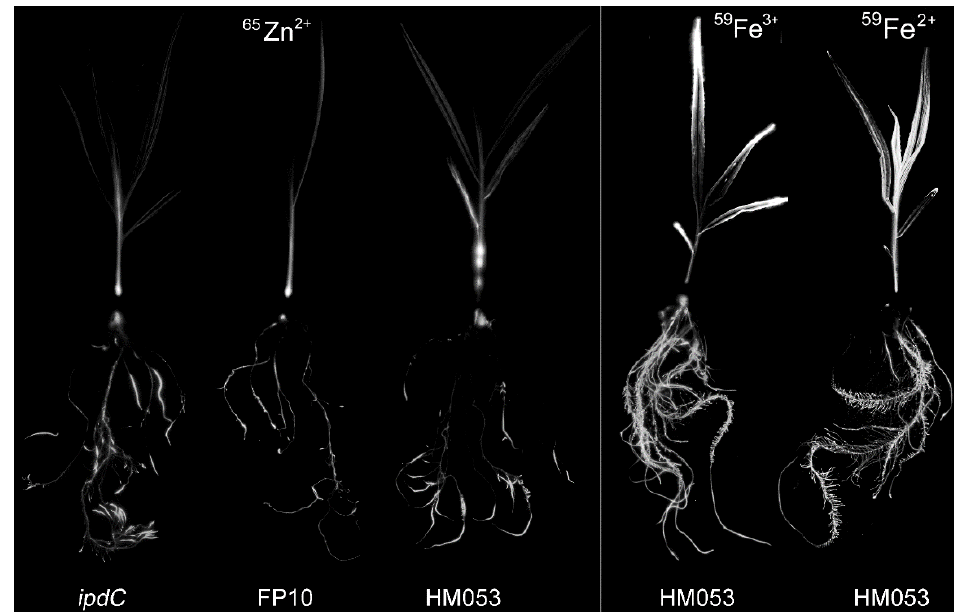
Figure 5. Radiographic images of maize plants after exposure to 65 Zn as a function of inoculation with ipdC , FP10, and HM053 bacteria. For comparison, we also show radiographic images of maize plants after exposure to 59 Fe 3+ and 59 Fe 2+ radiotracers from our prior work [16]. These plants were also inoculated with HM053, which was shown to exert the greatest influence on host 59 Fe 3+ and 59 Fe 2+ uptake and allocation.